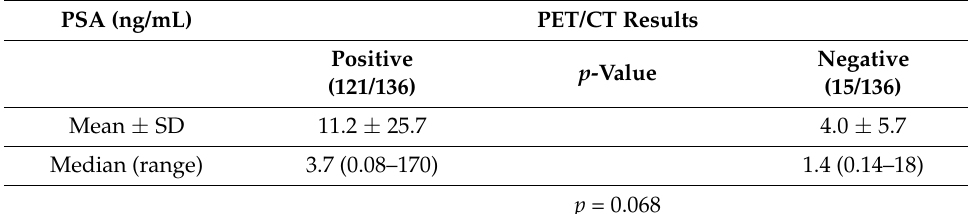
Table 4. Positive vs. negative [ 68 Ga]Ga-PSMA-11 PET/CT results in relation to PSA.